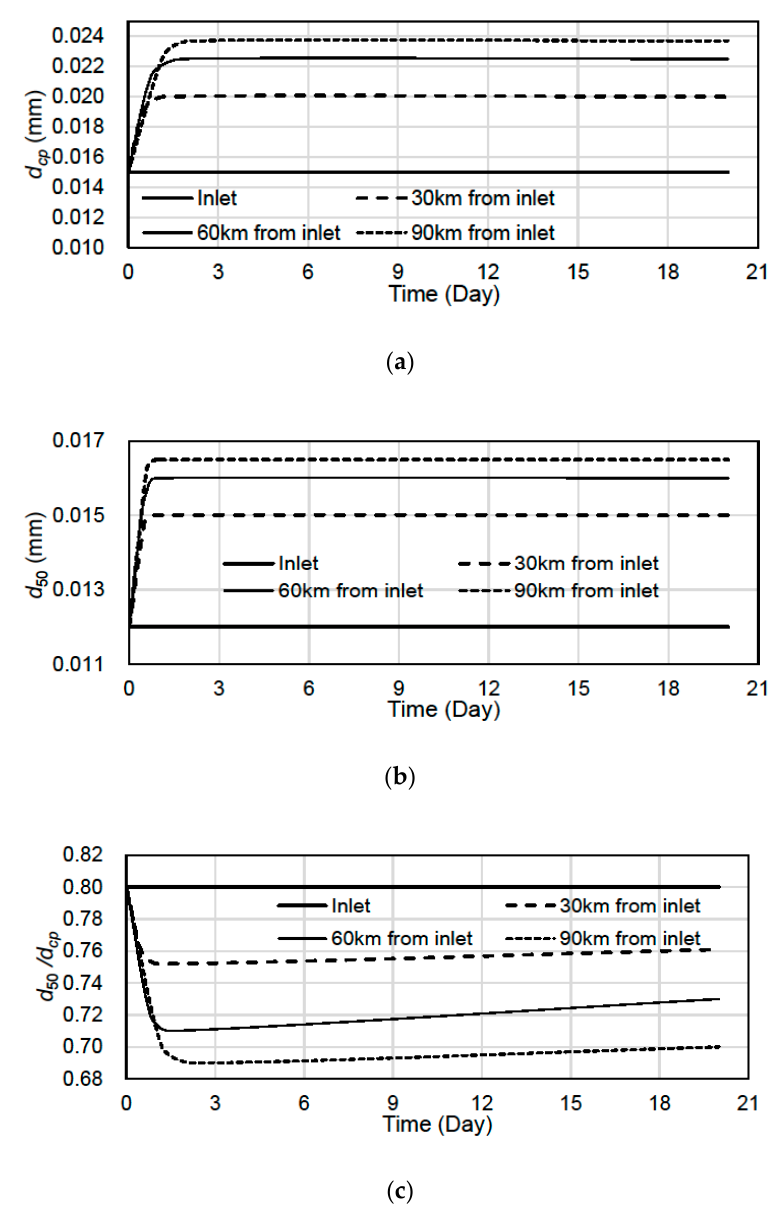
Figure 4. Temporal variation in the suspended-load under erosion conditions. ( a ) d cp ; ( b ) d 50 ; and ( c ) d 50 / d cp